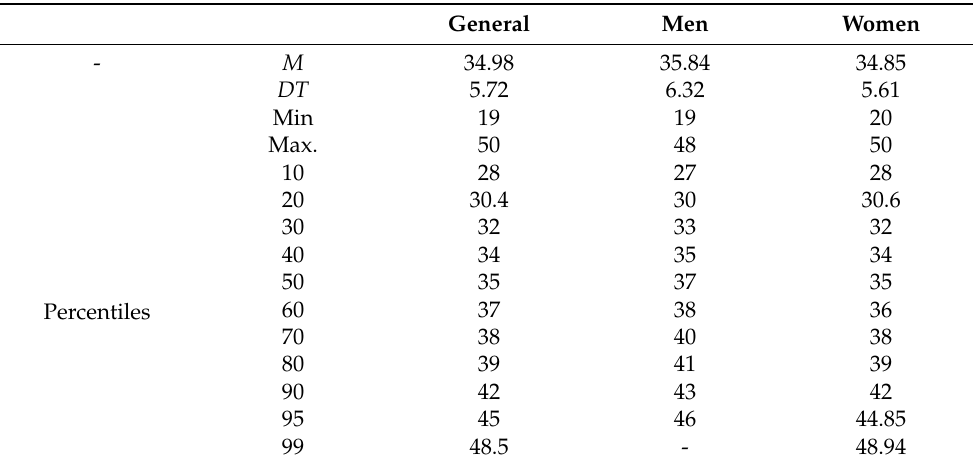
Table 3. Scales for the nursing population: general and by